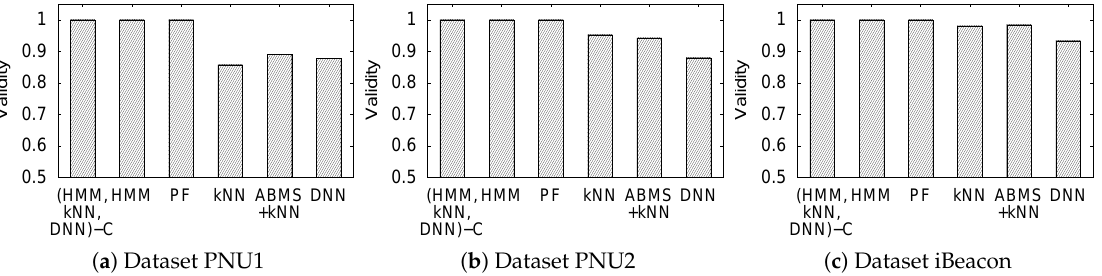
Figure 15. Validity of indoor positioning with constraints and the other